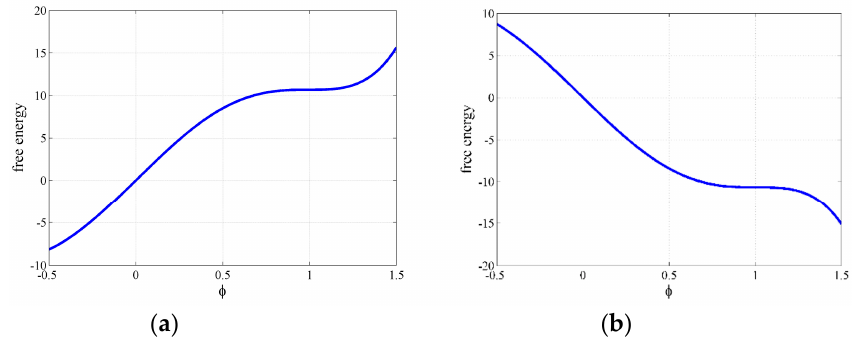
Figure 6. Uneven free energy: ( a ) ω = 1 and T − T c = 20 K; and ( b ) ω = 1 and T − T c = − 20 K.